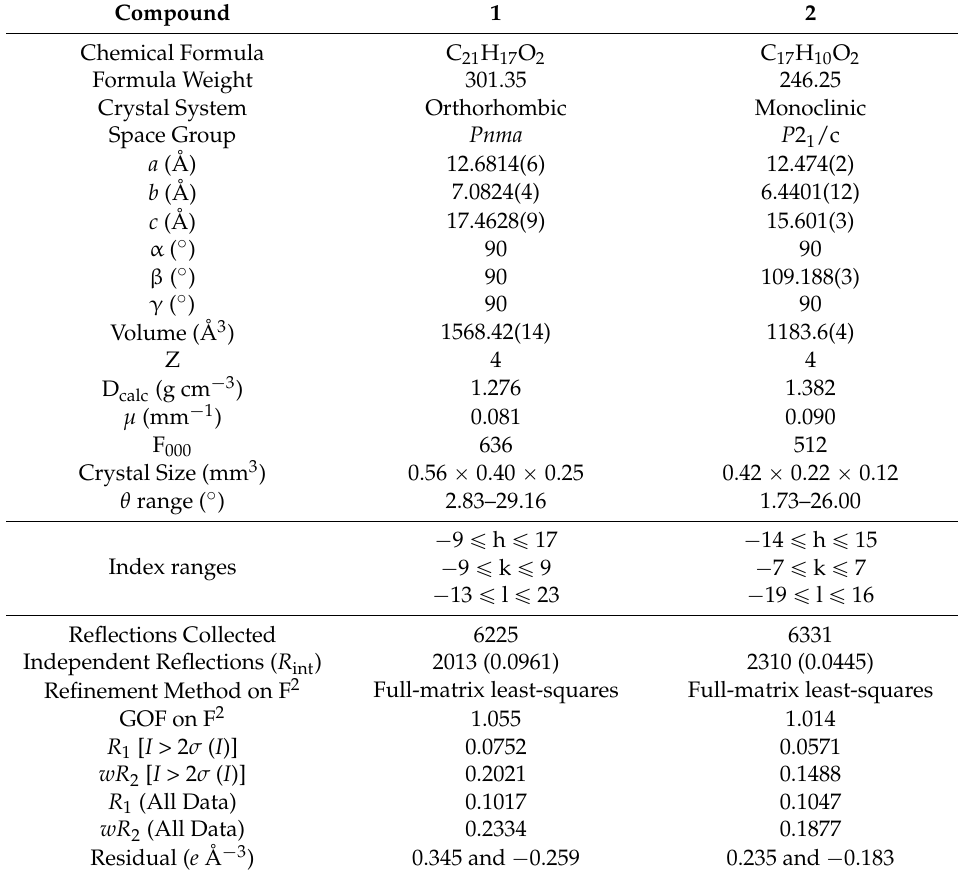
Table 1. Crystallographic data for compounds 1 and 2